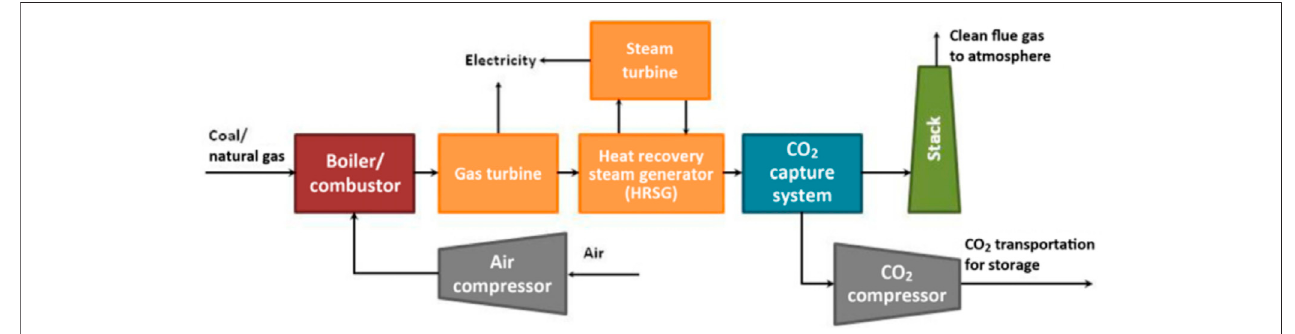
FIGURE 2 | Schematic diagram of the combustion CO 2 capture device of a coal- fi red power plant (Zaman and Lee,